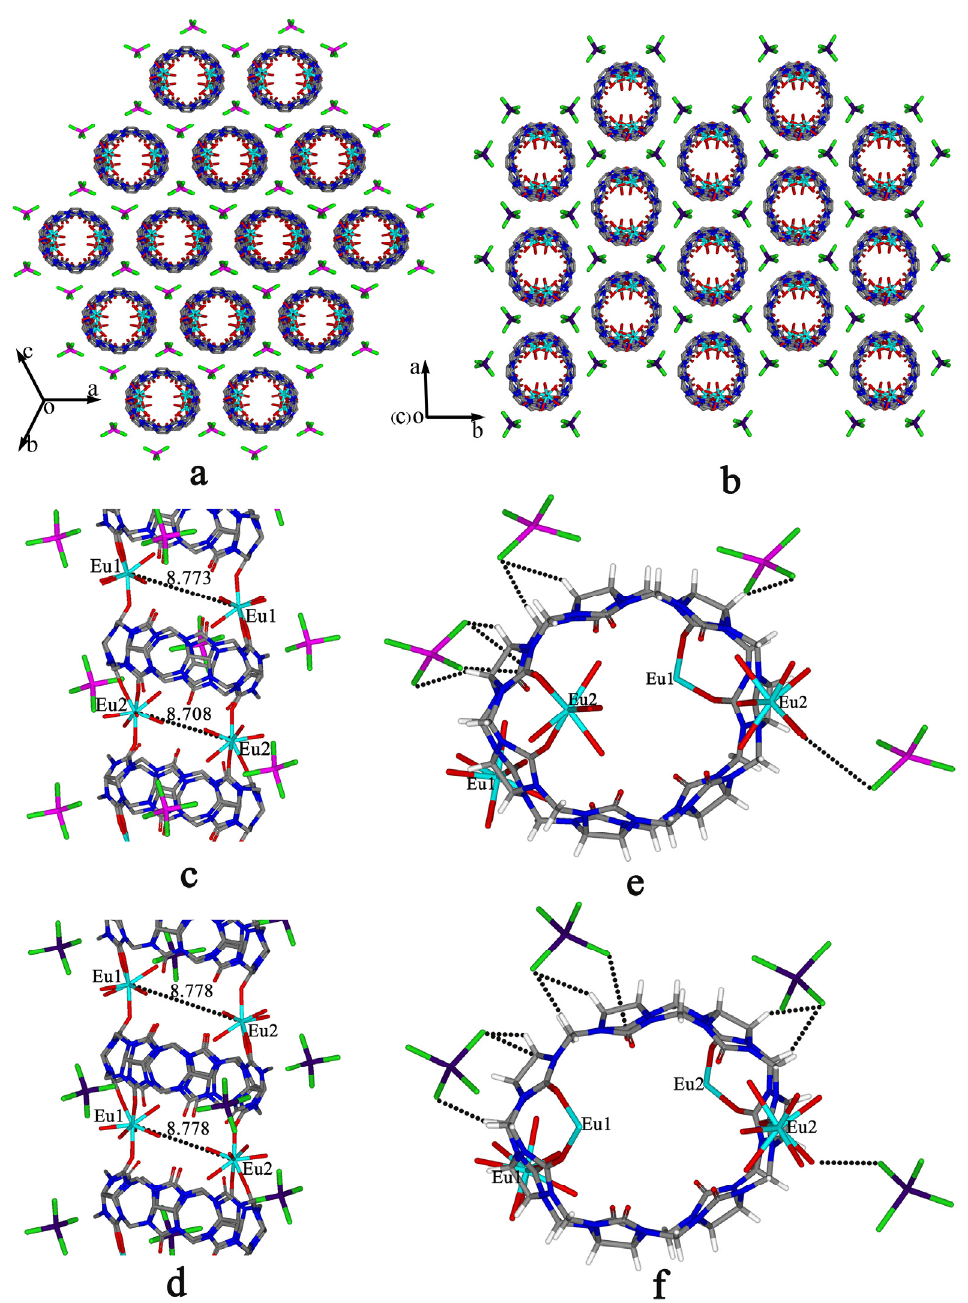
Figure 2. X-ray crystal structure of compounds with light lanthanides: ( a ) and ( b ) an overall view of the coordination features and supramolecular assembly; ( c ) and ( d ) 1D coordination polymer ofEu 3+ cations and Q[7] molecules surrounded by the [CuCl [CoCl ] 2 − anions; ( e ) and ( f ) interaction of the [CuCl 4 compounds 5 and 9 ,